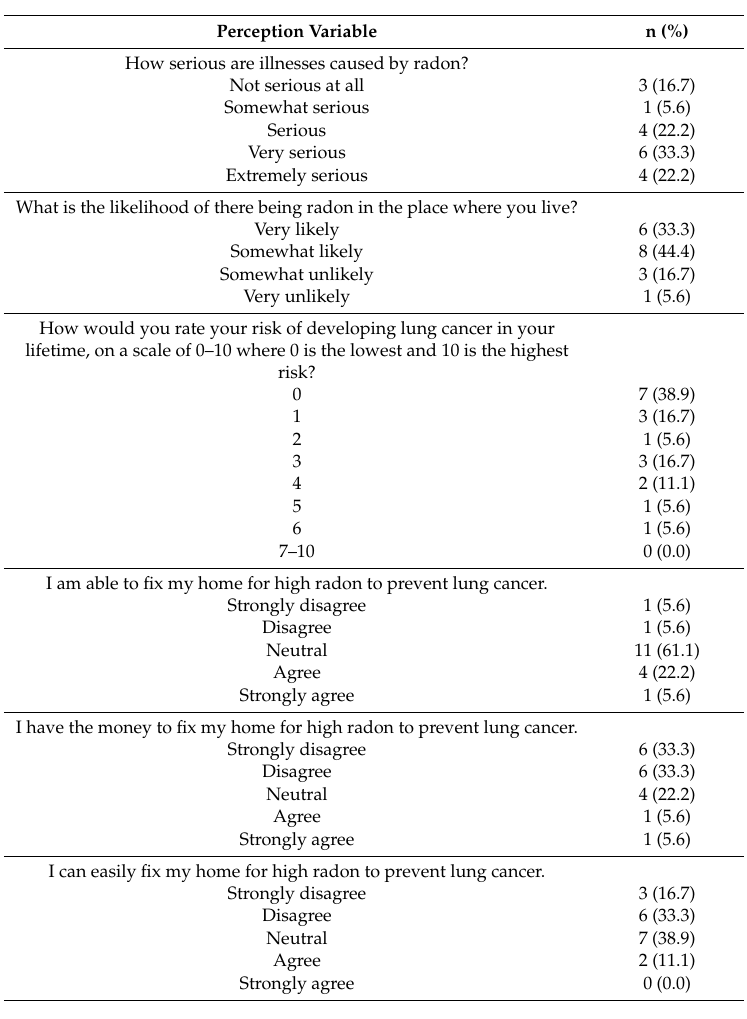
Table 1. Homeowners’ perception of severity, risk, and ability to mitigate for radon (N = 18). Perception Variable n (%) How serious are illnesses caused by radon? Not serious at all 3 (16.7) Somewhat serious